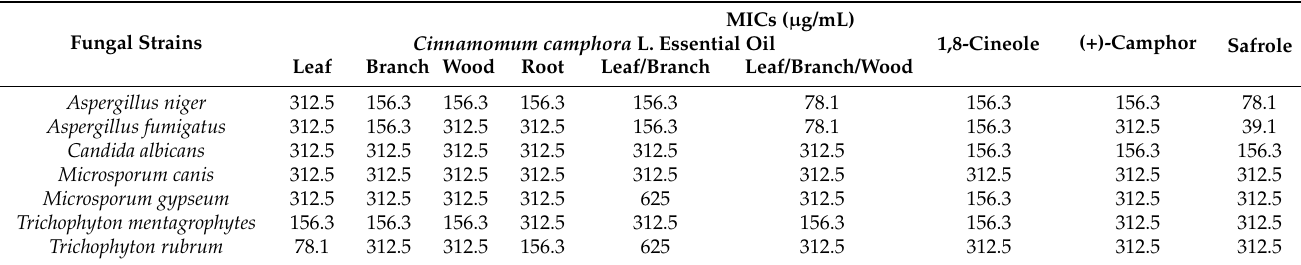
Table 5. Minimum inhibitory concentrations (MICs) of the Cinnamomum camphora L. essential oil against the tested fungal strains. Fungal